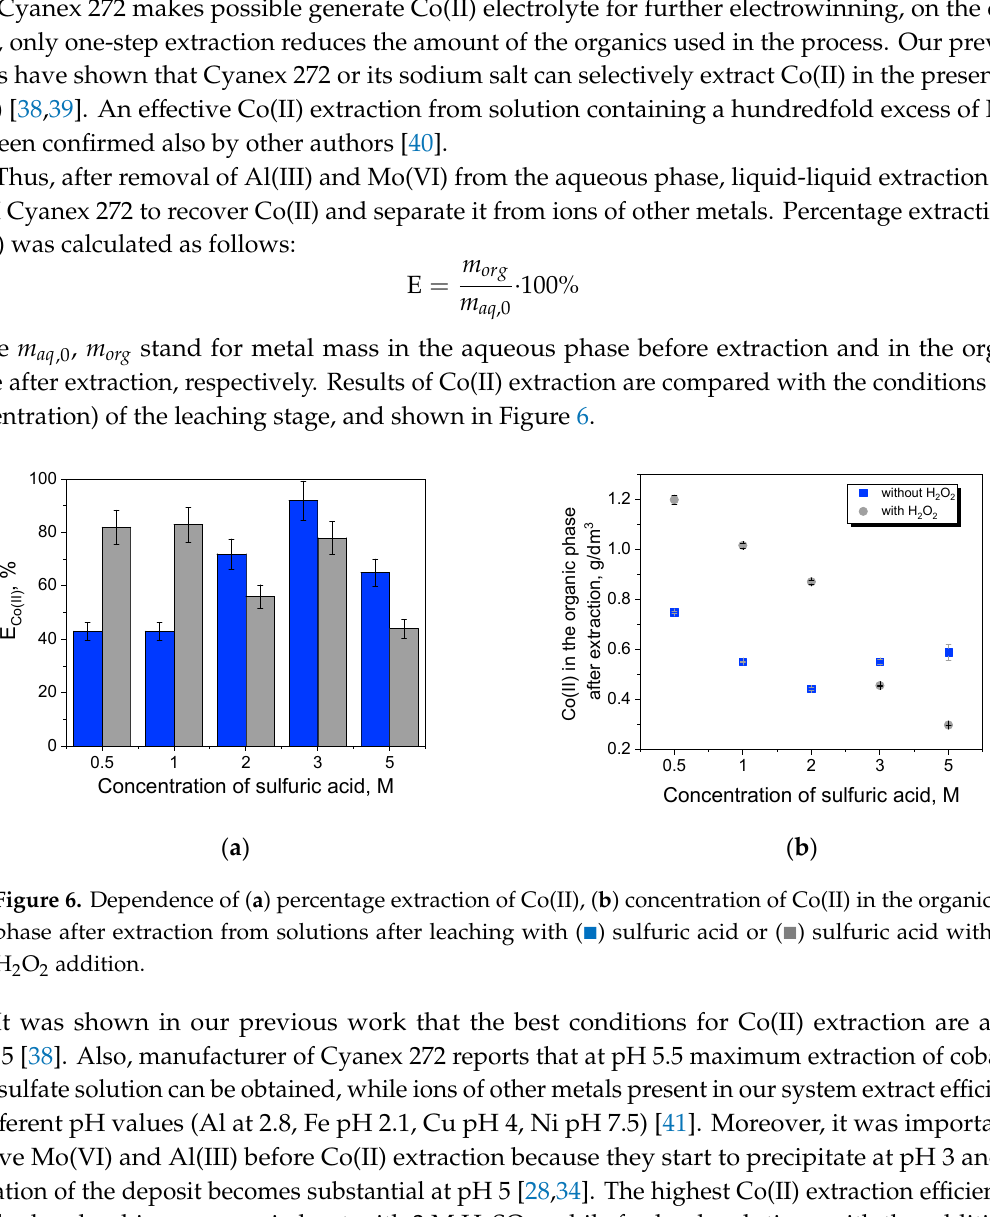
Table 4. Co(II) and Mo(VI) concentrations in the stripping phase (after the forth step of